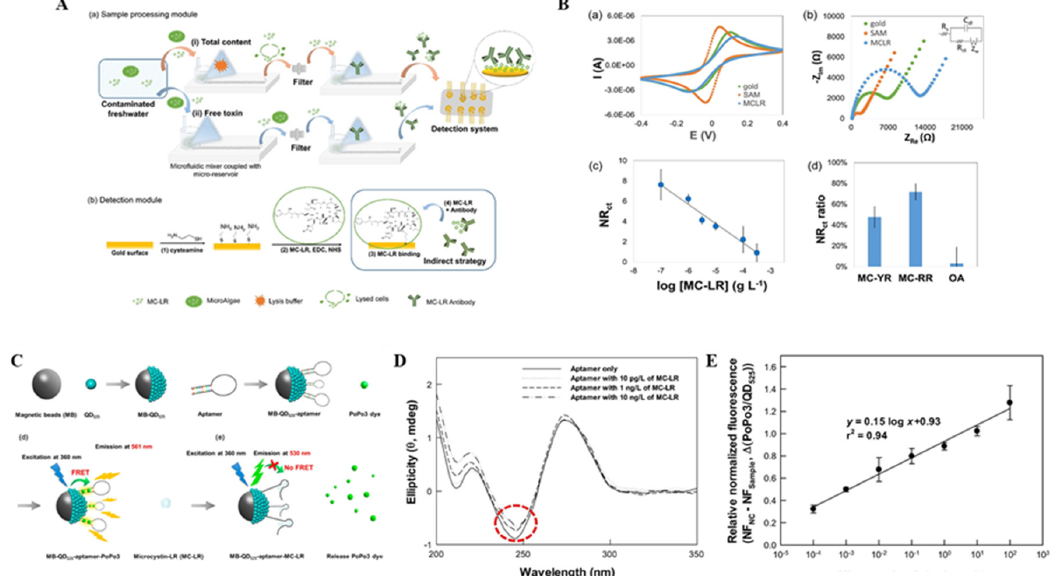
Figure 6. ( A ) Schematic representation of the overall MC-LR detection system. A sample processing system comprising ( a ) sample processing and ( b ) detection modules. Consists of (i) two microfluidic mixers coupled and (ii) reservoirs ( µ FM- µ R) used to process freshwater cyanobacterial samples without lysis buffer. ( b ) Immunosensor fabrication; (1) diagram of SAM with cysteamine, (2) MC-LR activation, and (3) MC-LR binding to a SAM-modified surface. ( B ) Nyquist plots for ( a ) cyclic voltammetry and ( b ) surface functionalization steps; (inset) Randles equivalent circuit model used for EIS fitting. ( c ) Normalized signal of R ct versus the MC-LR concentration (concentration of antibody 10 − 2 g/L). ( d ) Percentage of NRct signals obtained for the same concentration (10 − 4 g/L) of different toxins (MC-YR, MC-RR, OA). ( C ) Schematic representation of the MC-LR detection procedure of the FRET-based QD–aptasensor. ( D ) Circular dichroism (CD) spectral changes of the aptamer with MC-LR. ( E ) Sensitivity validation for MC-LR detection after 6 h of reaction. Reproduced with permission from [114,115], published by Elsevier, 2019.